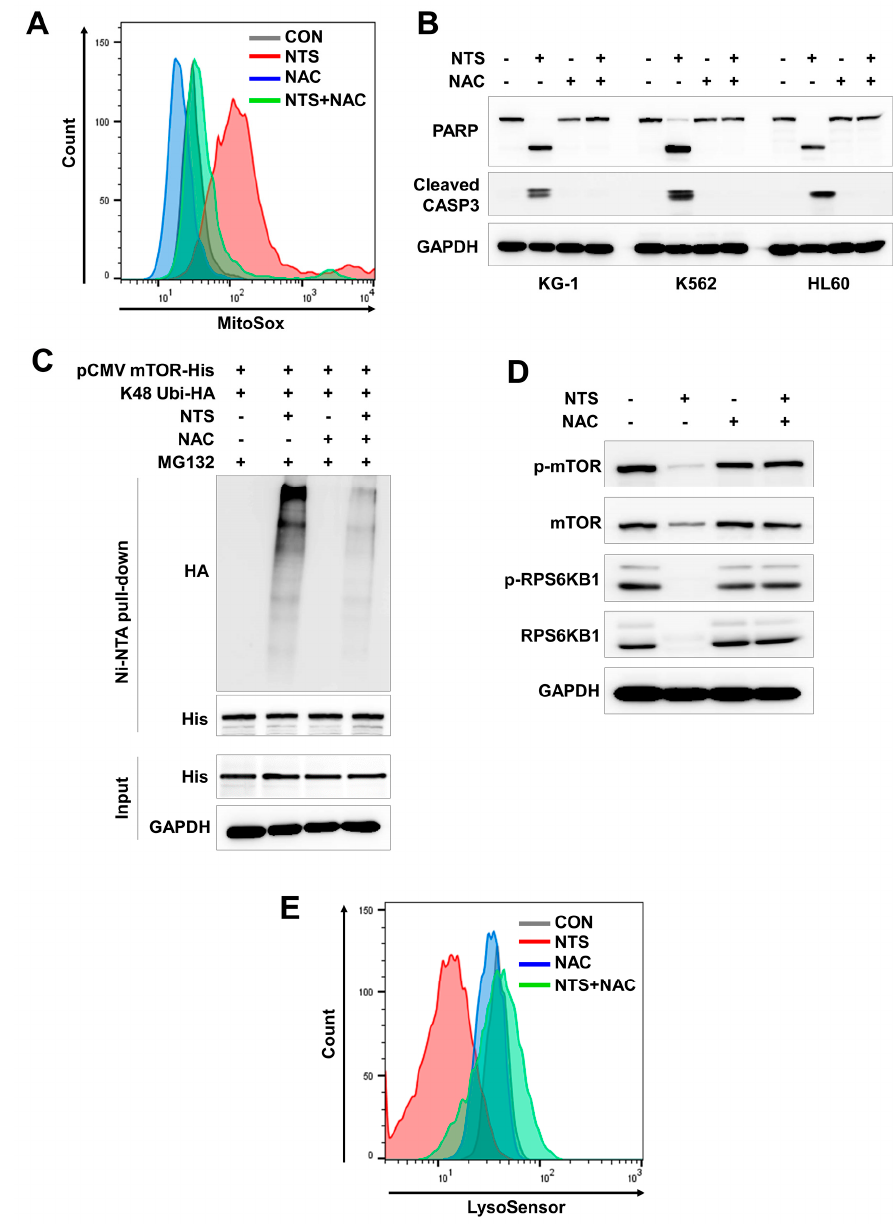
Figure 5. Antileukemic e ff ects of NTS-induced ROS are mediated through mTOR ubiquitination. ( A ) NTS-induced increase in levels of mitochondrial ROS. ROS levels were determined by FACS analysis using the MitoSox in K562 cells treated with NAC prior to NTS treatment. ( B ) Western blot of cleaved PARP and CASP3 in K562 cells treated with NAC prior to NTS treatment. NTS-derived ROS plays a crucial role in leukemia cell death. ( C ) ROS inhibition leads to failure of mTOR ubiquitination. mTOR ubiquitination determined by Ni-NTA His-pull down ubiquitination assay in K562 cells transfected with the indicated plasmids, pretreated with NAC prior to NTS treatment and proteasome inhibition with MG132 (10 µ M). ( D ) NAC prevents NTS-induced downregulation of mTOR / RPS6KB1 signaling. ( E ) Lysosome activity is a ff ected by NTS-derived ROS. NAC was pre-incubated for 1 hour and then NTS was added for a further 24 hours. After 24 hours, lysosome activity was assessed by FACS analysis using